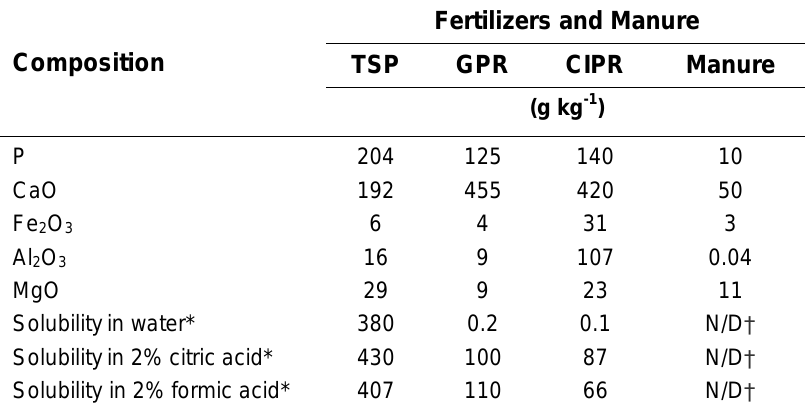
Characteristics of the Fertilizers